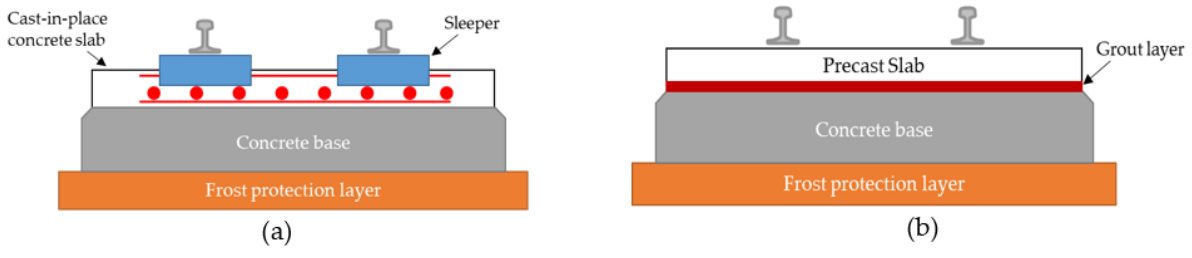
Figure 1. Concrete slab track systems: ( a ) Cast-in-place slab track, ( b ) Precast slab track.